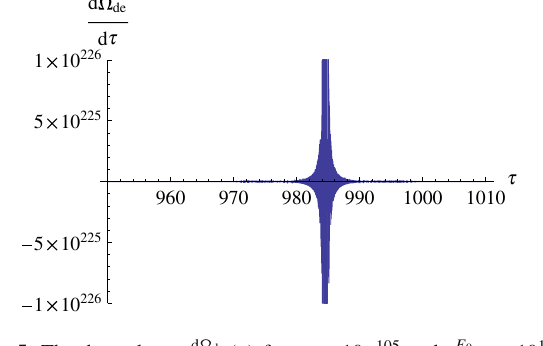
Fig. 4 The dependence (cid:5) de (τ) for α = 0 . 2 ( left figure ) and α = 0 . 4 ( medium figure ) and α = 0 . 8 ( right figure ) and E 0 rescaled time τ for the left figure is given in units of [ 5 . 3 × 10 − 145 s ] , for the center figure is given in units of [ 2 . 0 × 10 − 145 s ] and for the right figure is given in units of [ 3 . 3 × 10 − 146 s ]